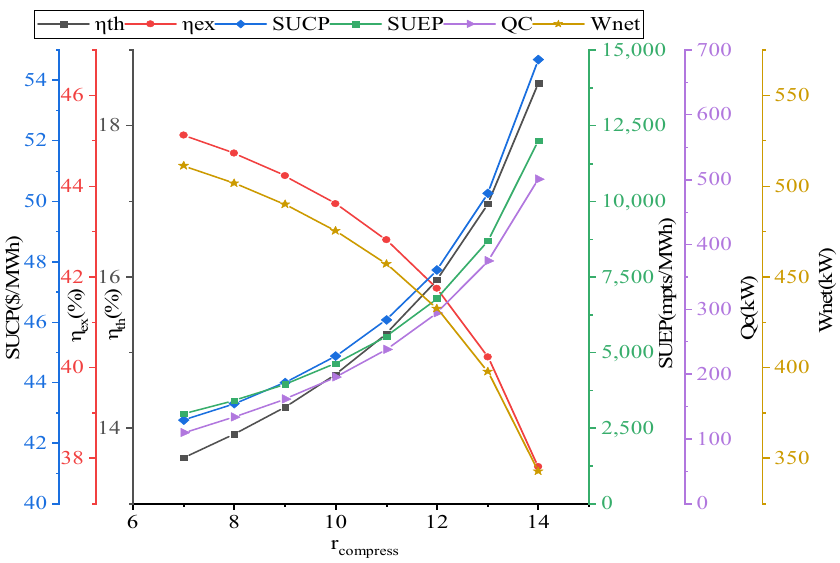
Figure 8. Effect of the compression ratio on system performance.